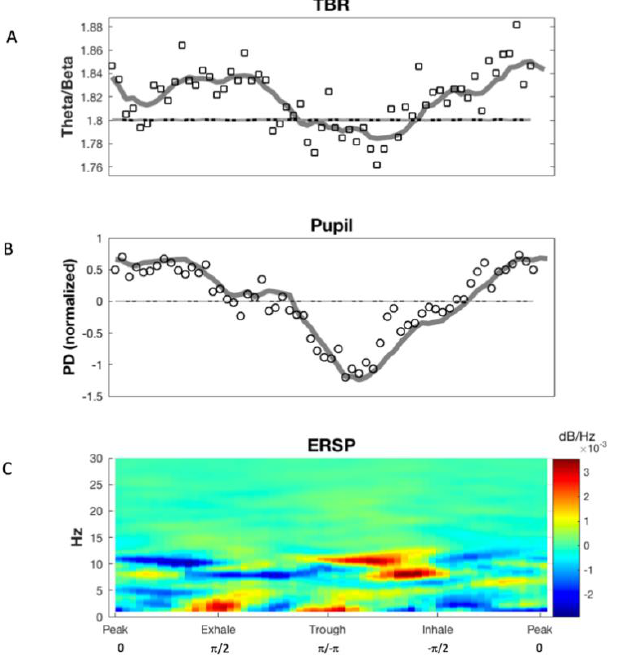
Figure 3. Resulting waveforms of moving phase window method. Bottom phase axis denoted in C by both radians and descriptive terms signifying respiratory phase. Dotted lines ( A , B ) show means and 99.73% confidence intervals for surrogate resampling distributions ( n = 10,000). ( A ). TBR at π/4 radian window size, with 0.25 radian iterative advance (solid black line) and π/30 (unfilled squares; zero overlap) used in statistical analysis. ( B ). PD waveform (from normalized pupil time series) using the same methodology as A (above). Unfilled circles indicate π/30 moving phase window (zero overlap) data points. ( C ). ERSP at π/30 (non-overlapped) resolution, baseline subtracted. Note prominent alpha-respiratory synchronization during early inhalation.